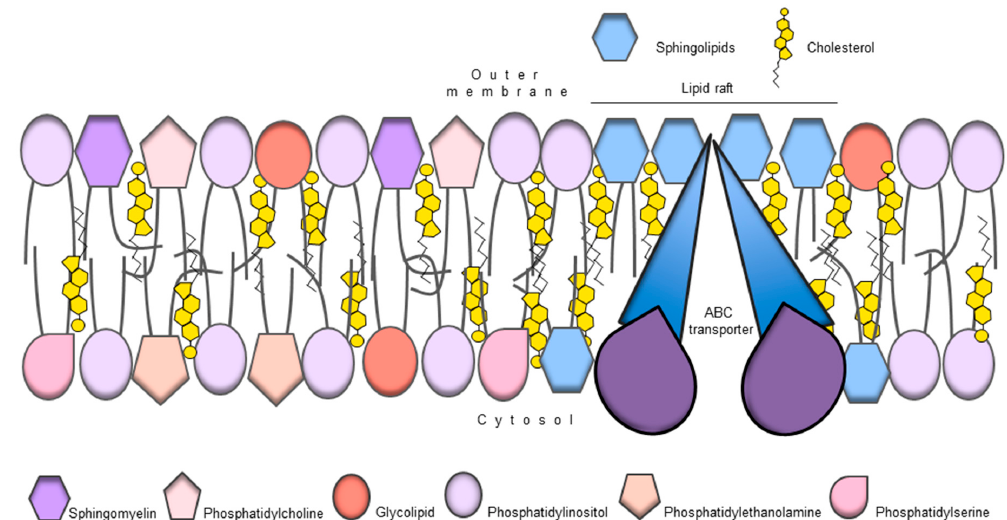
Figure 2. ABC transporters as regulators of membrane lipid composition. ABC transporters can flop lipids from the inner to the outer membrane leaflet, helping to create an asymmetric distribution of lipids between the two membrane leaflets. For example phosphatidylethanolamine and phosphatidylserine are preferentially located in the inner membrane leaflet whereas phosphatidylcholine is preferentially located in the outer membrane leaflet. This distribution may contribute to cell signalling or as structural support contributing to ABC transporter function.